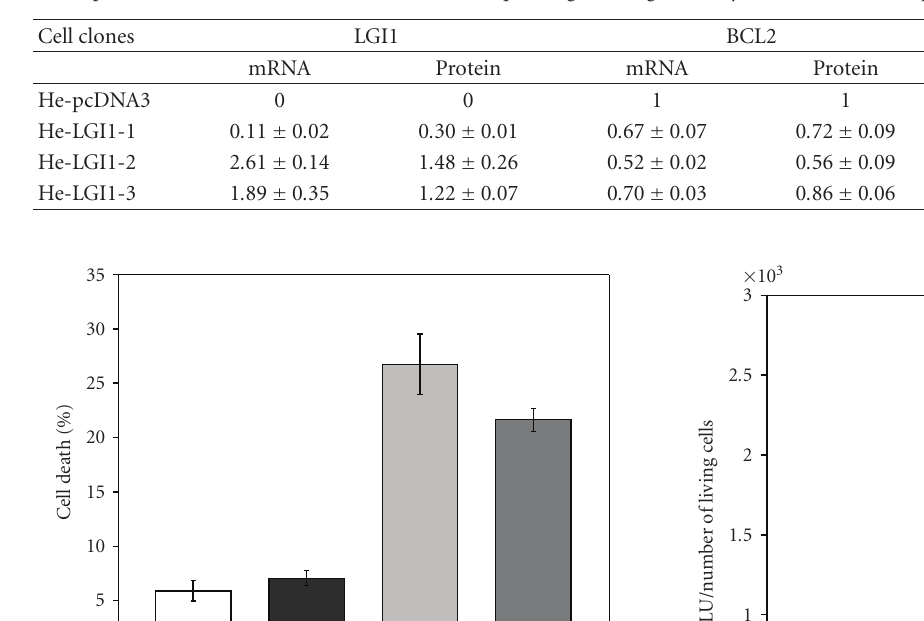
Table 1: Quantification of LGI1, BCL2, and BAX expression in HeLa cell clones. The net intensity values were determined by densitometry and normalized to the average GAPDH content of each cell sample. The values of BCL2 and BAX are shown as ratio with He-pcDNA3 values. The expression of BCL2 and BAX in all cell clones expressing LGI1 significantly di ff ers from that of pc-DNA3 cells ( n = 3 − 6; P < . 01).